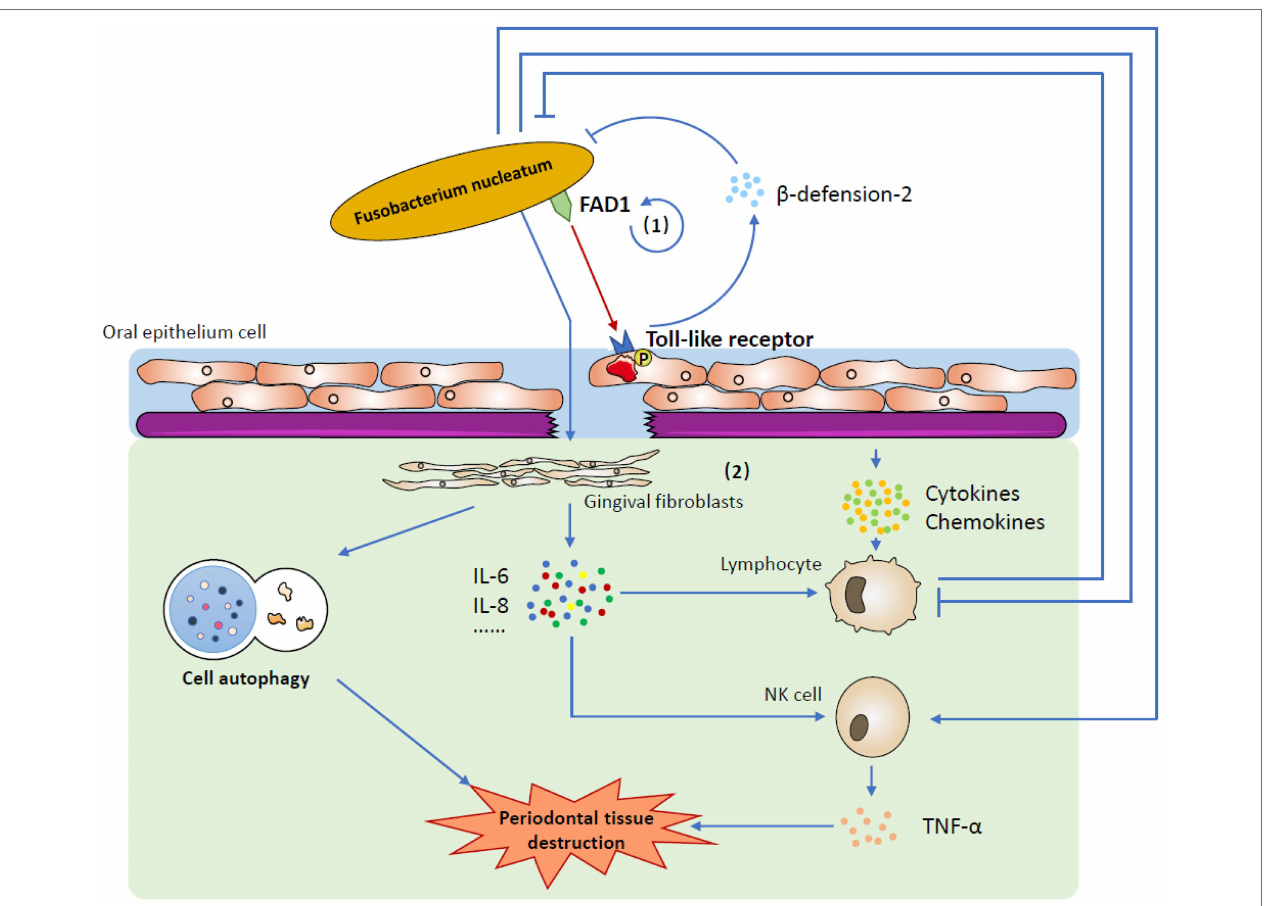
FIGURE 2 | The mechanism by which Fusobacterium nucleatum induces host responses. (1) Under healthy conditions, one of the most important factors is that Fusobacterium nucleatum uses FAD-I to stimulate gingival epithelial cells to express human beta-defensin-2 via gingival epithelial cell Toll-like receptors. Stimulated human beta-defensin-2 helps to defend against invading microbes, including Fusobacterium nucleatum itself, and maintains homeostasis in the complex oral environment. (2) In a state of disease, Fusobacterium nucleatum destroys the epithelial barrier and affects human gingival fibroblasts. It not only induces cell autophagy but also stimulates the secretion of several cytokines and chemokines. When challenged by Fusobacterium nucleatum , the immune system is activated to eliminate invasive bacteria. However, Fusobacterium nucleatum could restrain the human immune system to reduce this removal effect. Moreover, the production of TNF- α from activated NK cells may lead to periodontal tissue